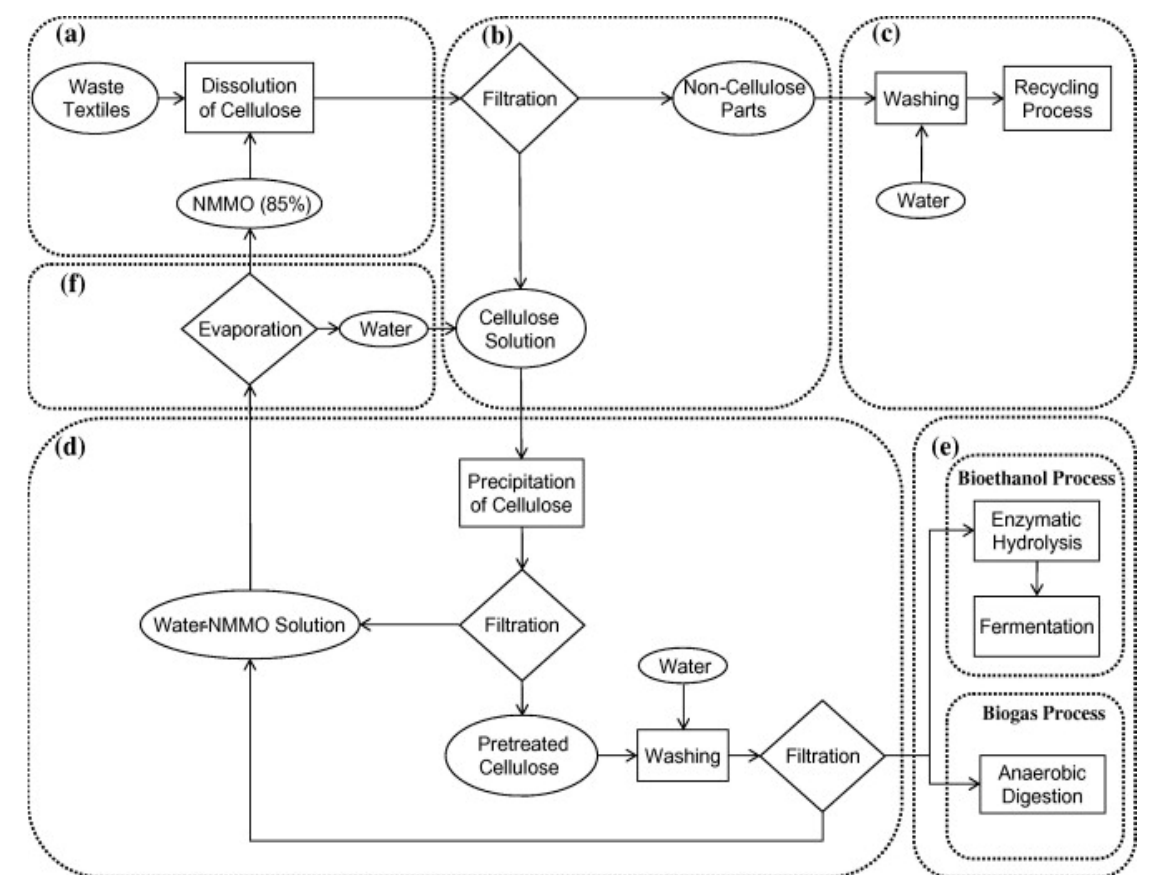
Figure 9. Cellulose separation from waste textiles using NMMO solution with recycling of solvent: ( a )—mixing; ( b )—filtration; ( c ) —washing; ( d )—precipitation; ( e )—enzymatic hydrolysis; ( f )— evaporation. Reprinted with permission from Ref. [51]. vent: ( a )—mixing; ( b )—filtration; ( c )—washing; ( d )—precipitation; ( e )—enzymatic hydrolysis; ( f )—evaporation. Reprinted with permission from Ref.